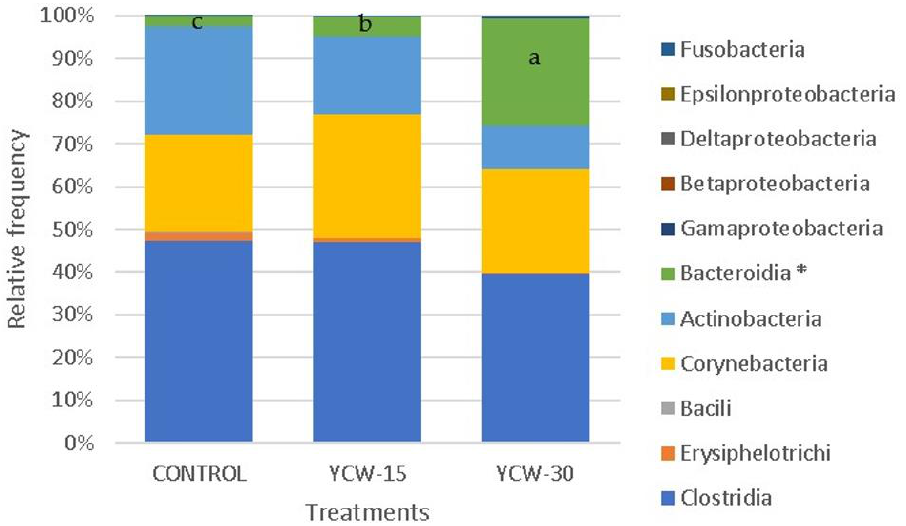
Figure 4. Relative frequency variation of the main fecal bacterial classes in control, YCW-15, and YCW-30 groups. a,b,c Boxes with the same letters are similar at p ≤ 0.0015. * Classes with significant differences.